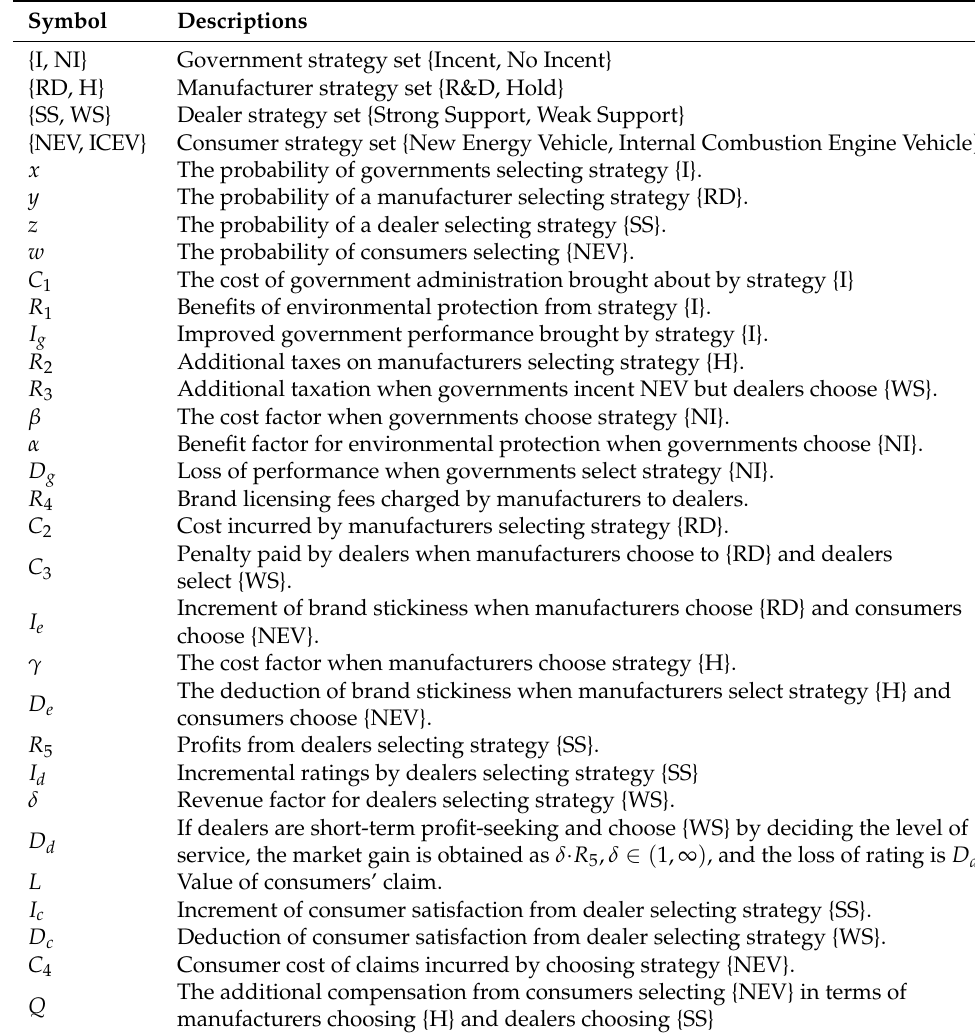
Table 1. List of